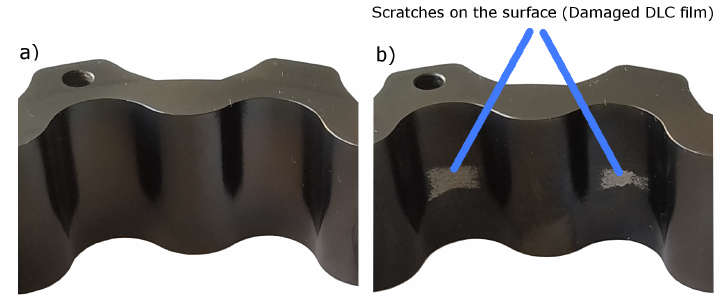
Figure 14. Surface appearance on the inner side of the floating outer ring ( a ) before and ( b ) after the